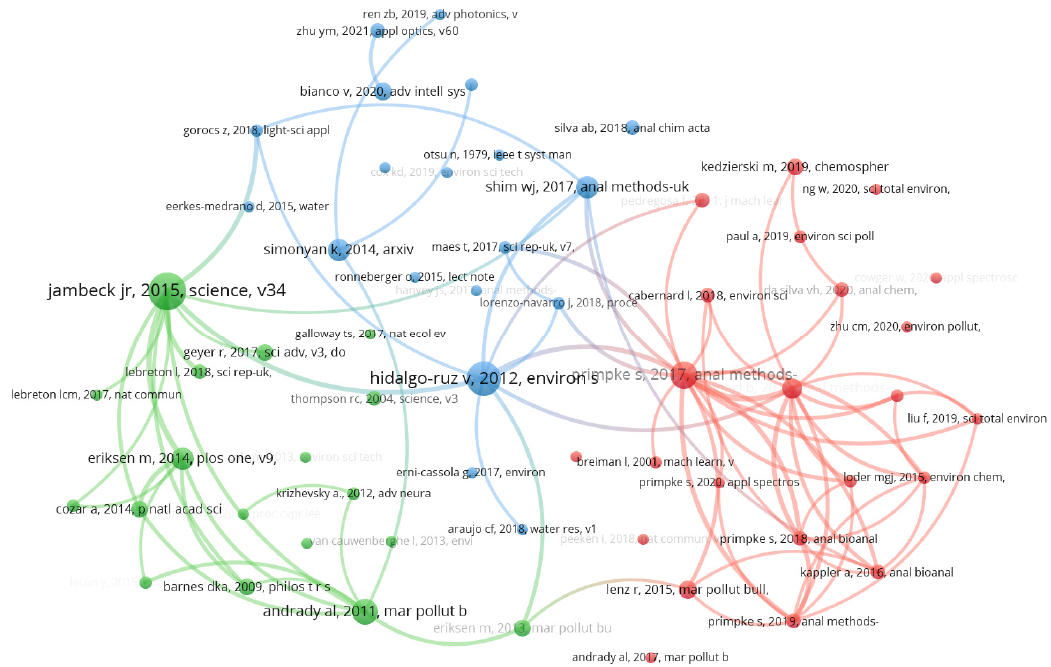
Figure 21. Co-cited reference network (visualized with VOSviewer).